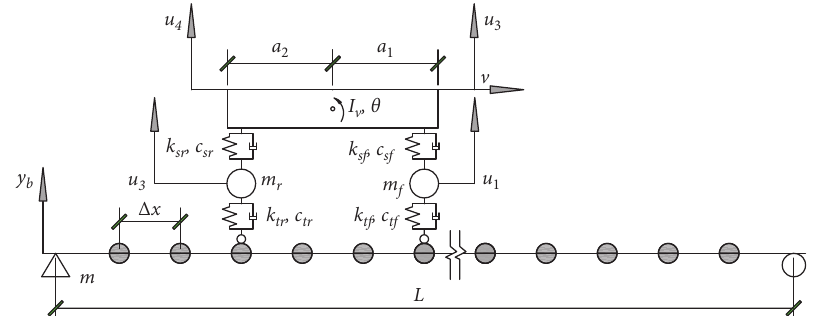
Figure 12: A 4-DOF model of the vehicle-bridge interaction system with different